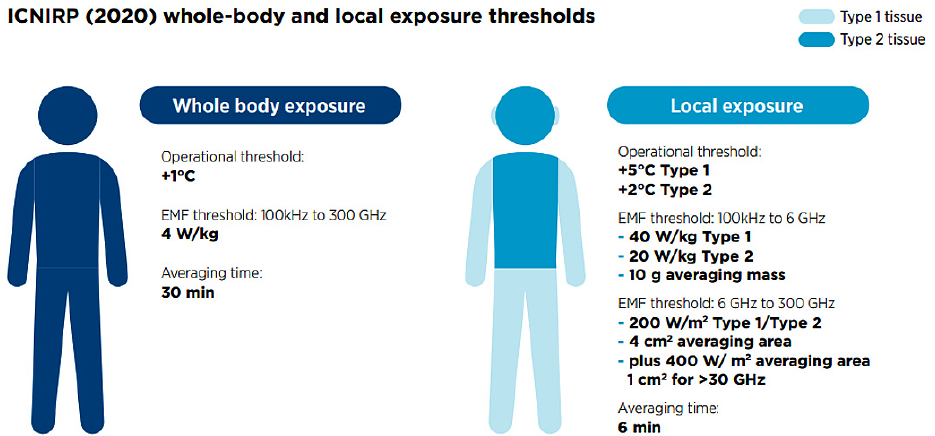
Figure 2. ICNIRP Whole- body and local exposure thresholds [9].